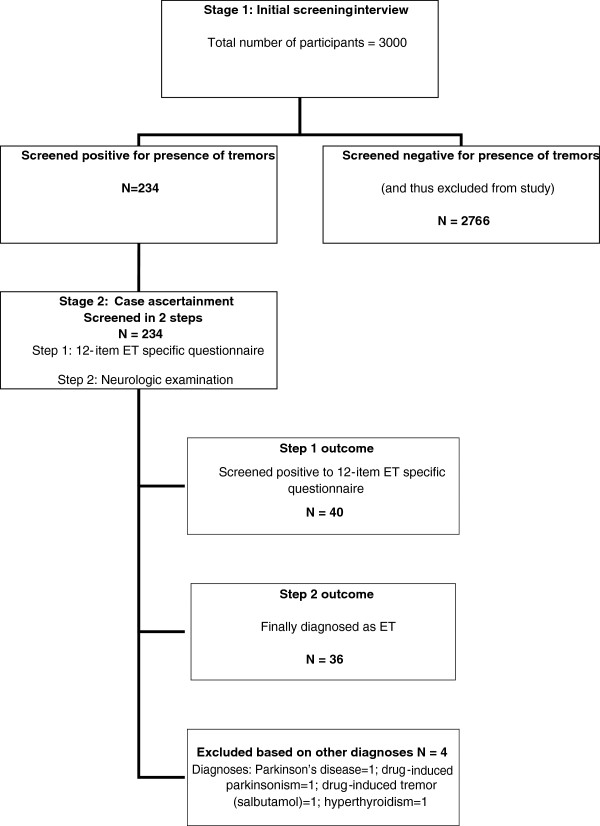
 Flow chart of participantevaluation and case ascertainment.